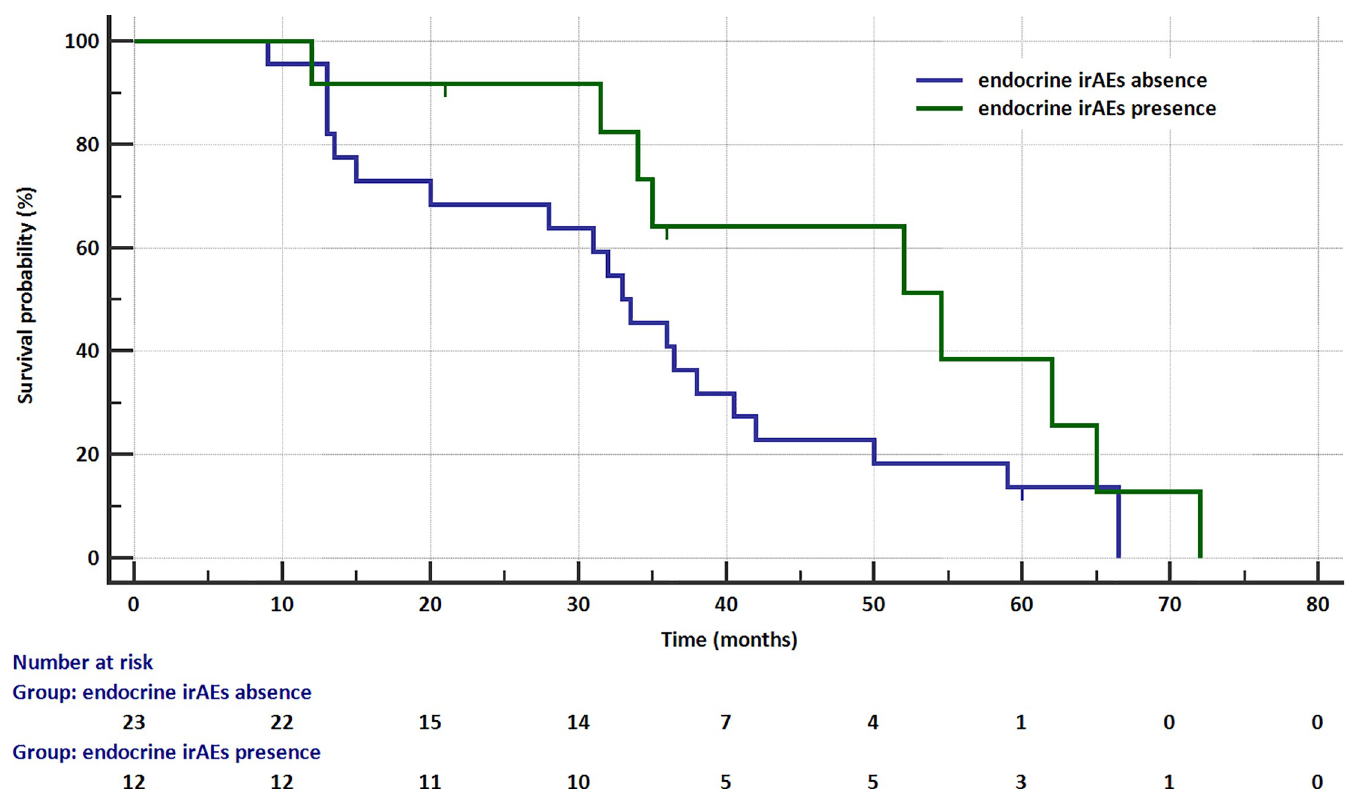
Fig 3. Kaplan-Meier overall survival curve in patients with and without endocrine irAEs.